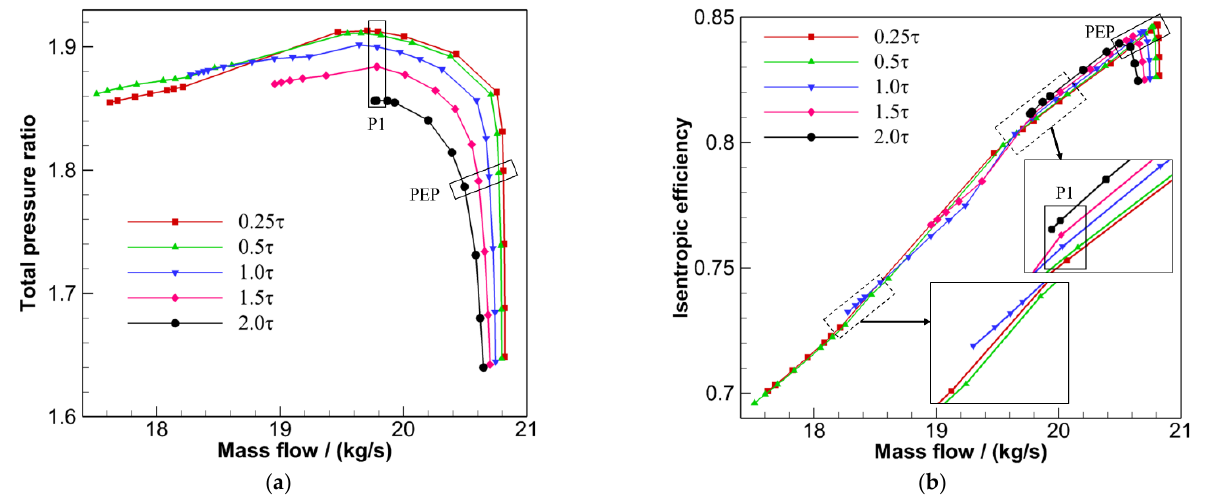
Figure 7. Compressor performance curves with different rotor tip clearances: ( a ) Total pressure ratio; ( b ) Adiabatic efficiency.